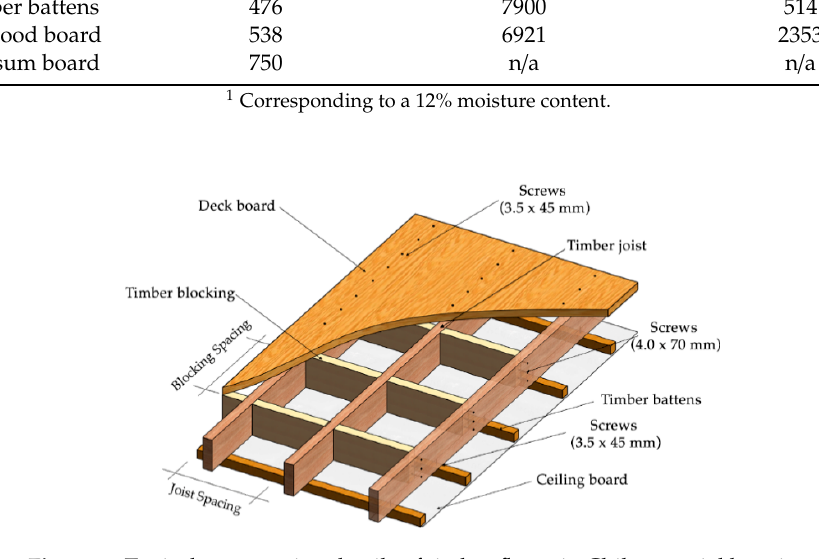
Figure 1. Typical construction details of timber floors in Chilean social housing.